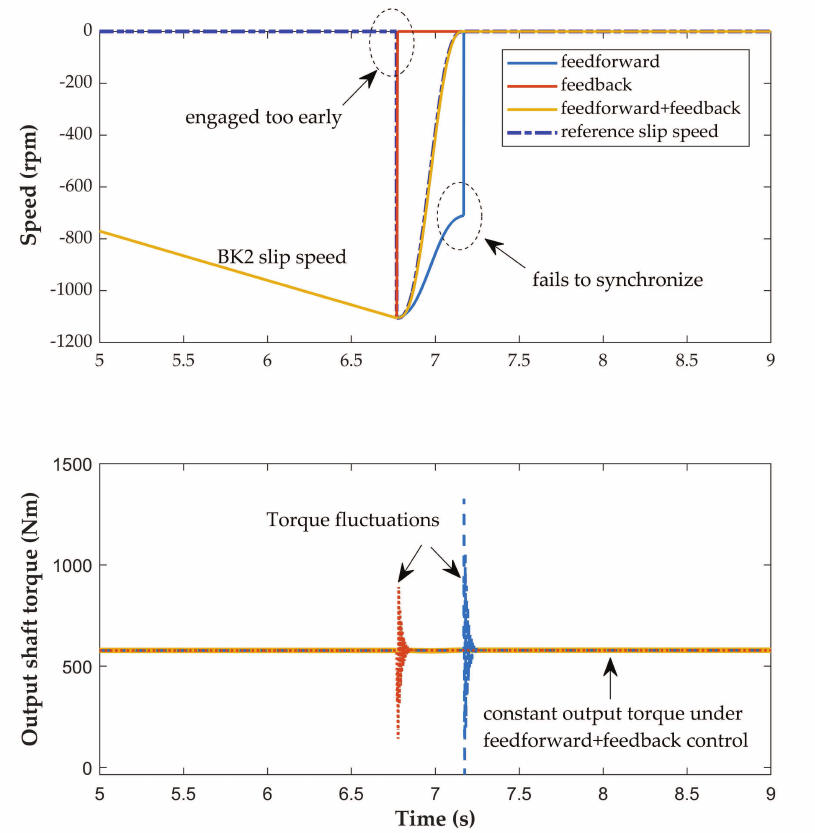
Figure 11. Comparison with pure feedforward and feedback